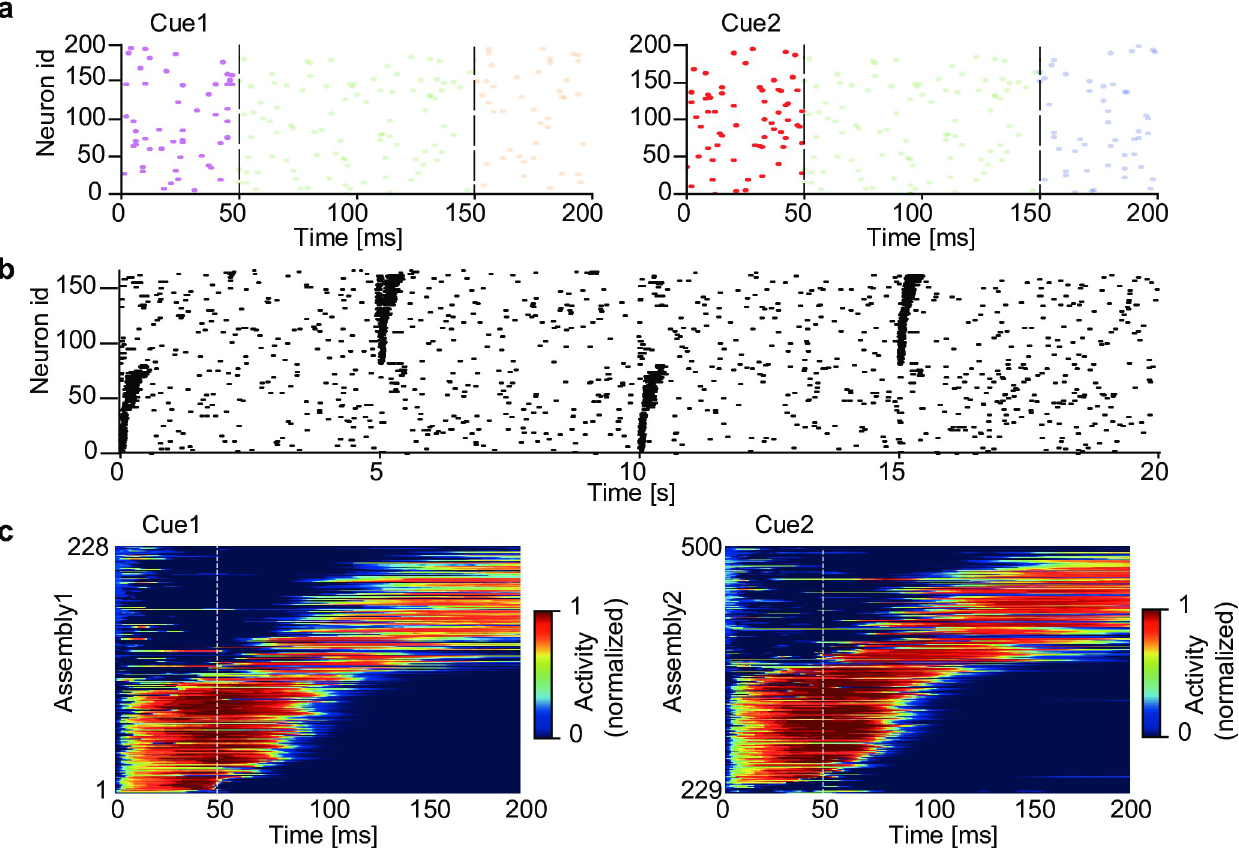
Fig 8. Spontaneous completion of learned sequences. The two chunks shown in Fig 2 were used for training a network having both recurrent gating and additive recurrent inputs. (a) In the testing phase, the first component pattern of each chunk (cue 1 or cue2; dark raster plots), but not the subsequent component patterns (light raster plots), was presented to the network. (b) The raster plot of network activities in the testing phase is shown. Cue 1 and cue 2 were presented alternately every 5 seconds. Neurons were sorted according to their onset response times, and only 160 out of the total 500 neurons are shown for the visualization purpose. (c) Sequential responses of the two assemblies were averaged over 20 trials. Vertical lines indicate the end of cue presentation. The sequential responses were evoked in the learned